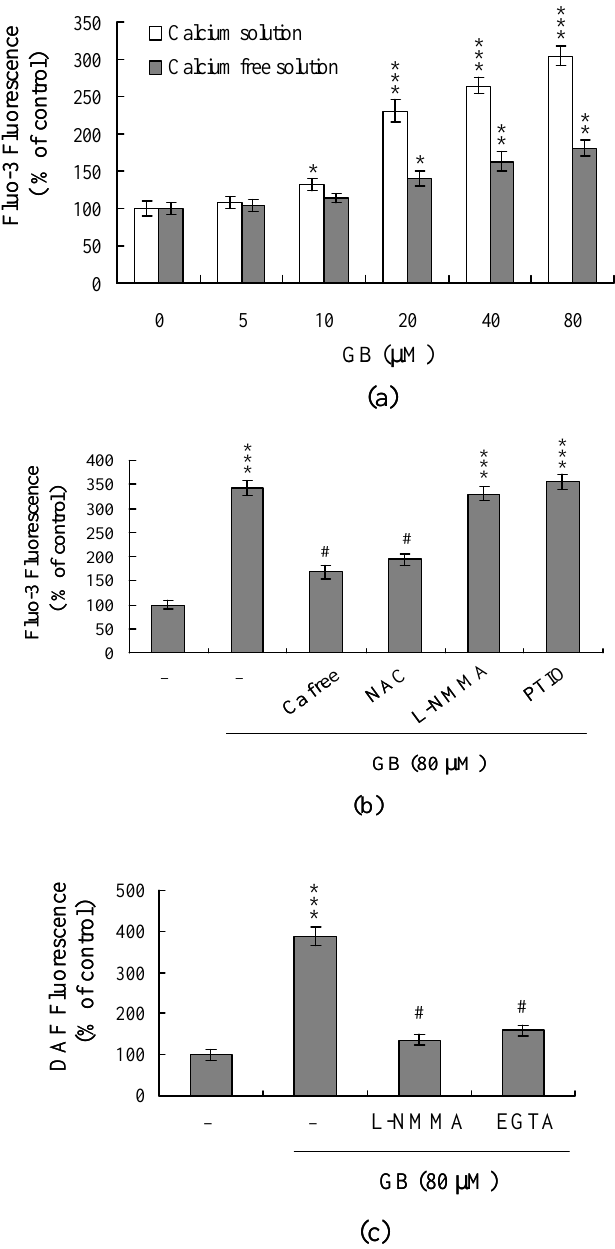
Figure 3. Ginkgolide B triggers changes in intracellular calcium and NO content in MCF-7 cells. (A) Cells were incubated with ginkgolide B (GB) as indicated for 24 h. Intracellular Fluo-3 fluorescence intensity was measured in the presence/absence of extracellular Ca 2+ . (B) We examined the intracellular Ca 2+ level changes triggered by treatment with ginkgolide B (GB; 80 µ M), and the effects of ROS and NO inhibitors (NAC: 300 µ M; L-NMMA: 400 µ M; PTIO: 20 µ M). (C) Cells were pretreated with L-NMMA (400 µ M) or EGTA (400 µ M) for 30 min and then incubated with ginkgolide B. Intracellular NO generation was measured by DAF-2DA fluorescence dye. Data are presented as percentage of control group. The data are representative of eight independent experiments. * P <0.05, **P<0.01 and *** P <0.001 versus the untreated control group; # P <0.001 versus the ginkgolide B-treated only